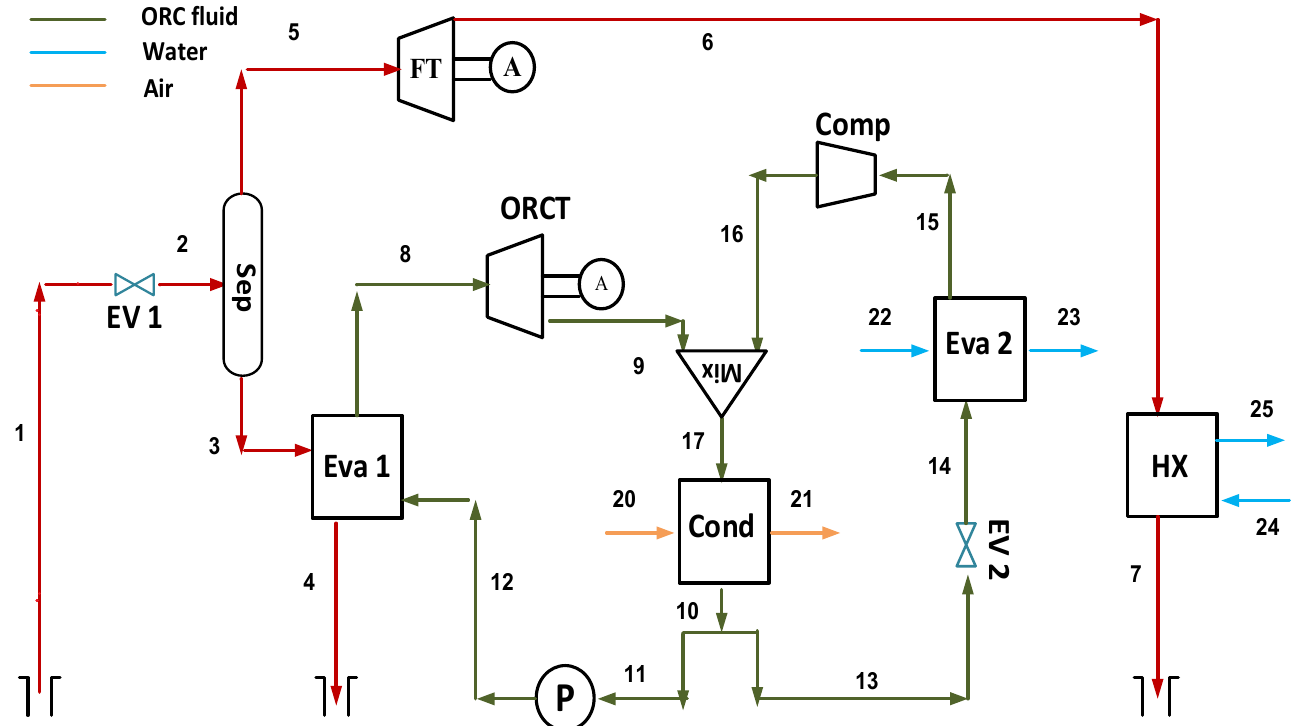
Figure 1. Schematic diagram of the evaluated flash-binary geothermal combined cooling heating and power. In this system, geothermal fluid (water) with the heat obtained from geothermal resources (point 1) passes through the expansion valve. After pressure reduction, it goes into two phases. In the separator, these two-phase separate into two lines. The separator is adiabatic and reversible, so it operates at the same temperature. After entering into a flash turbine, the vapor generates power and flows into the heat exchanger to produce hot water for residential consumption and then goes to the injection well. Saturated liquid flows into evaporator 1 and gets its heat to the ORC fluid (isobutane), and water goes to the injection well. The ORC fluid with high enthalpy flows into the ORC turbine and generates power, then flows into the mixer, and after mixing with fluid coming from the compressor, it goes into the condenser to cool down by entering the air. Afterward, ORC fluid is divided into two flows to regulate the cooling to power ratio ( α ), which in this study was considered as 0.2. Fluid through line 11 goes to the pump (to recirculate the ORC part for power generation) and through 14 flows into the expansion valve. After reducing the pressure by an expansion valve, it enters into an evaporator and absorbs heat from the water to produce cooled water for the cooling system, then flows into the compressor. The temperature-entropy (T–s) diagram is shown in Figure 2. In this figure, points 1, 4, and 7 are related to geothermal water.